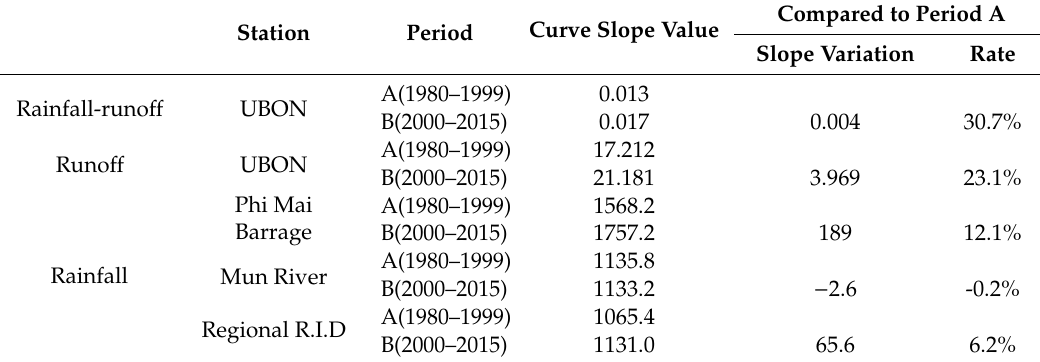
Table 4. Values and variations of slope calculated from the cumulative curves of rainfall against runo ff